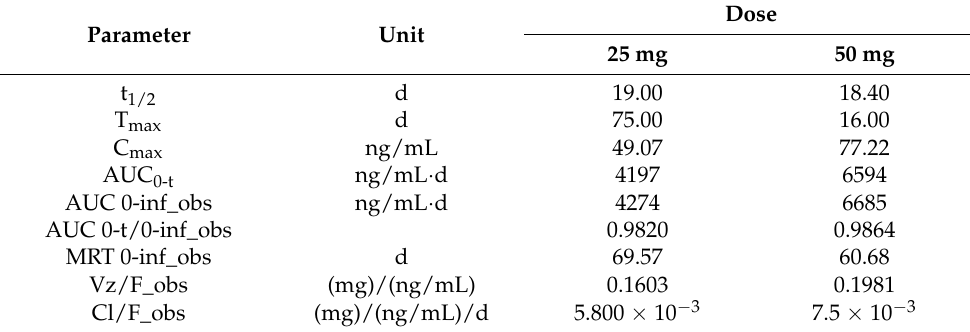
Table 5. Pharmacokinetic parameters of